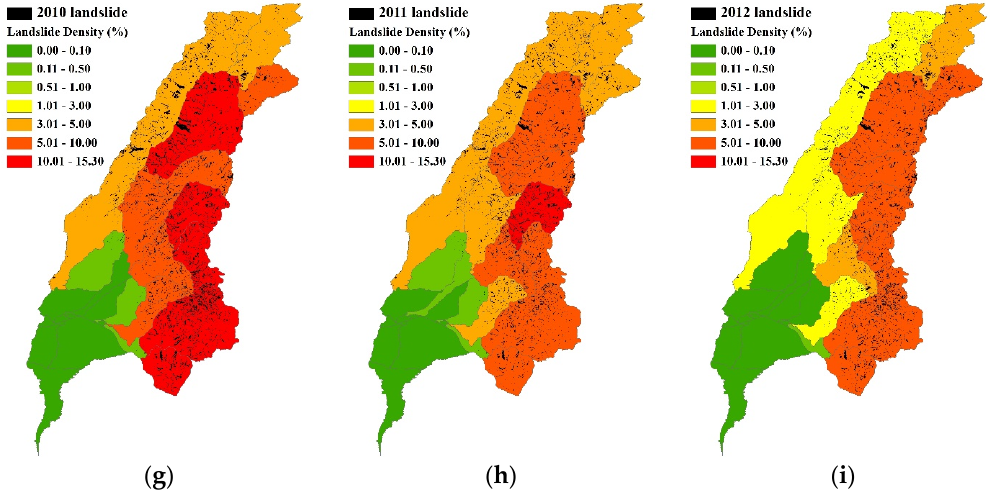
Figure 3. Annual landslide inventories and calculated landslide densities (total area of landslide for each sub-basin) for the catchment of GRD during ( a ) 2004; ( b ) 2005; ( c ) 2006; ( d ) 2007; ( e ) 2008; ( f ) 2009; ( g ) 2010; ( h ) 2011 and ( i )